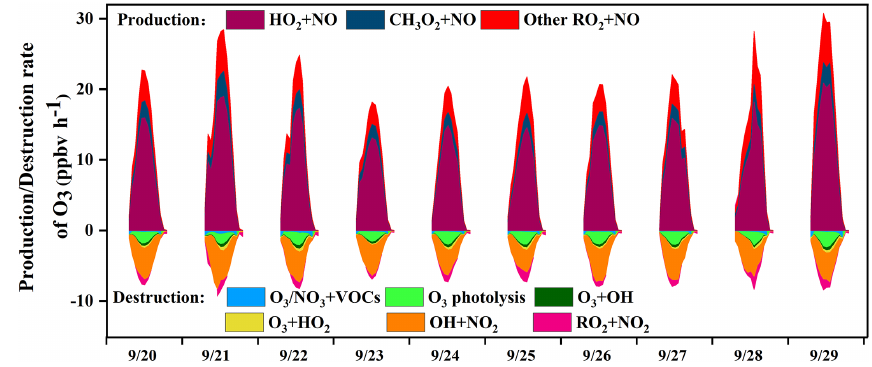
Figure 8. Time series of model-simulated O 3 chemical budgets during 20–29 September 2019 in